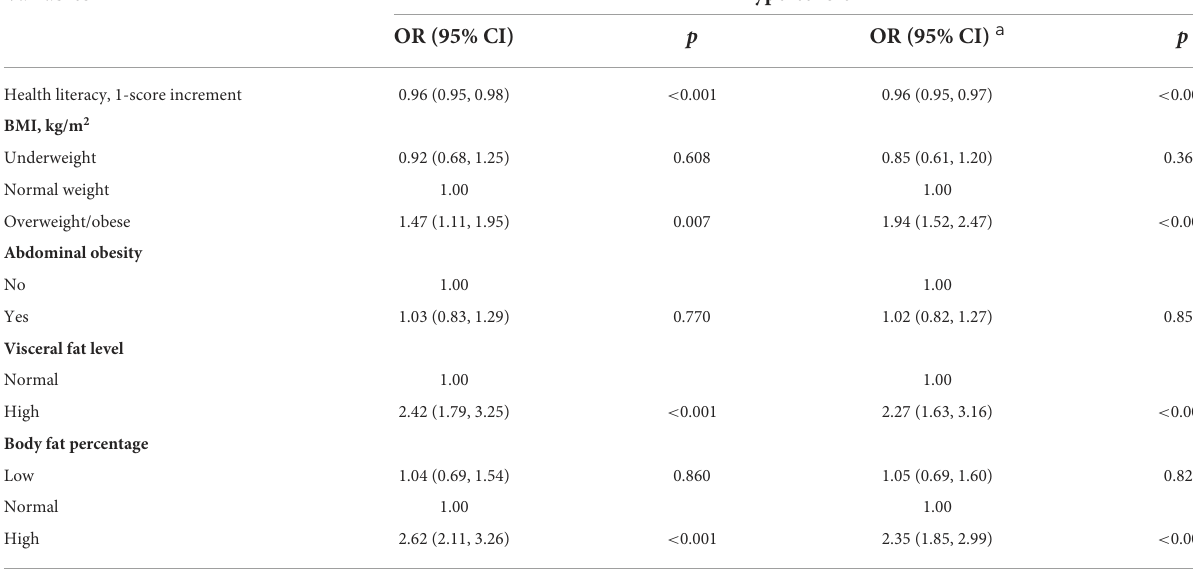
TABLE 2 Associations of BMI, abdominal obesity, body fat percentage, visceral fat level, and health literacy with hypertension ( n = 1,655).